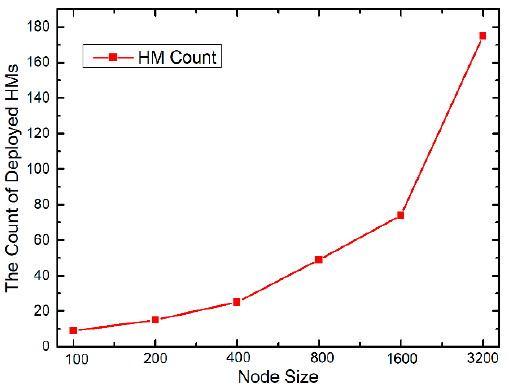
Figure 6. The count of deployed Hierarchical Elastic Areas Managers (HMs) with different node sizes.